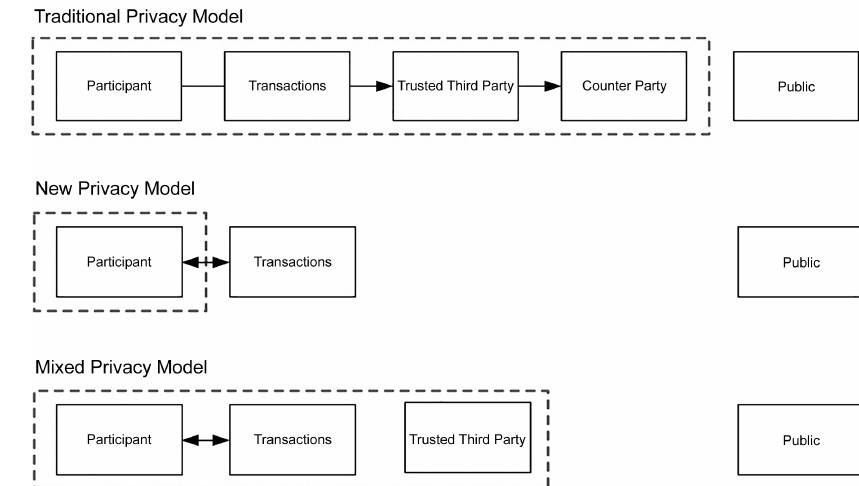
Figure 2. Blockchain privacy models based on Nakamoto